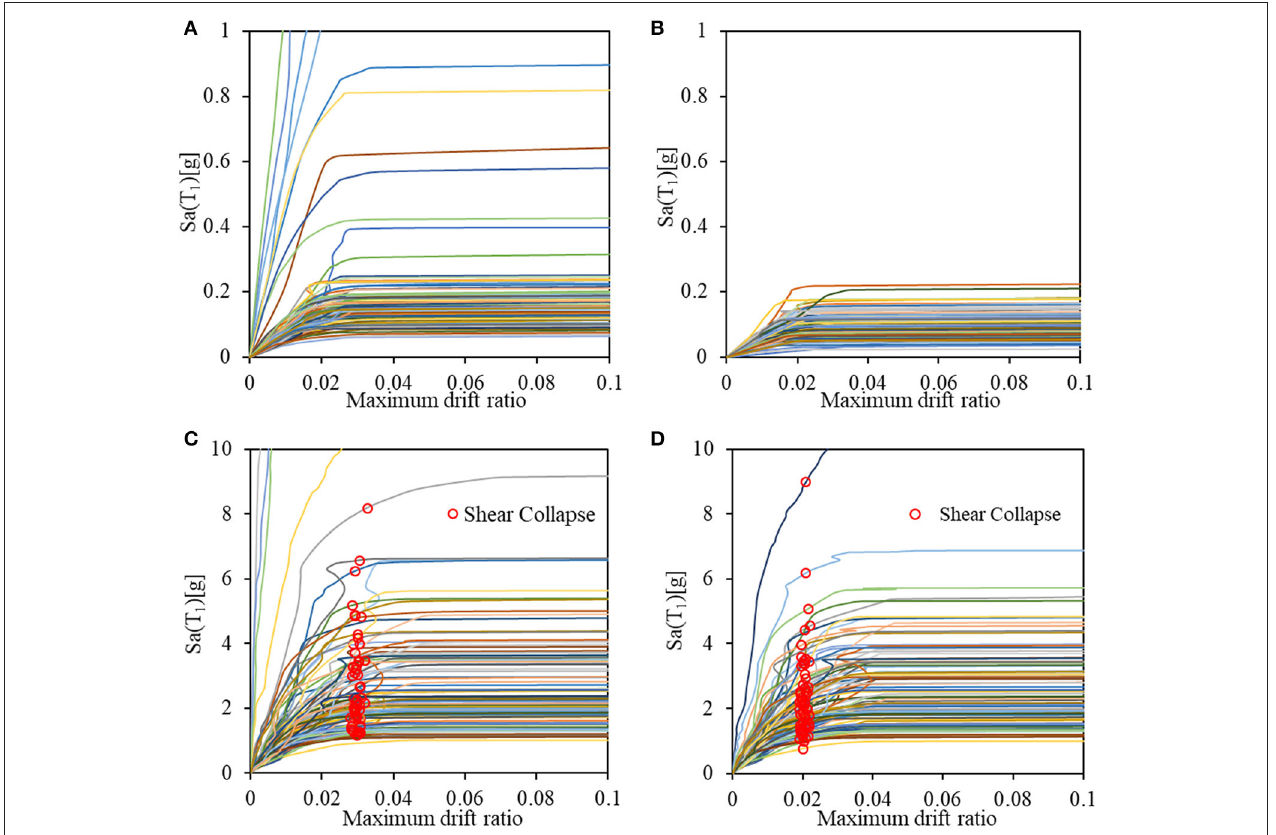
FIGURE 7 | Incremental dynamic analysis curves for 6-story buildings; (A) 6S_D_NI, (B) 6S_MD_NI, (C) 6S_D_I, and (D)